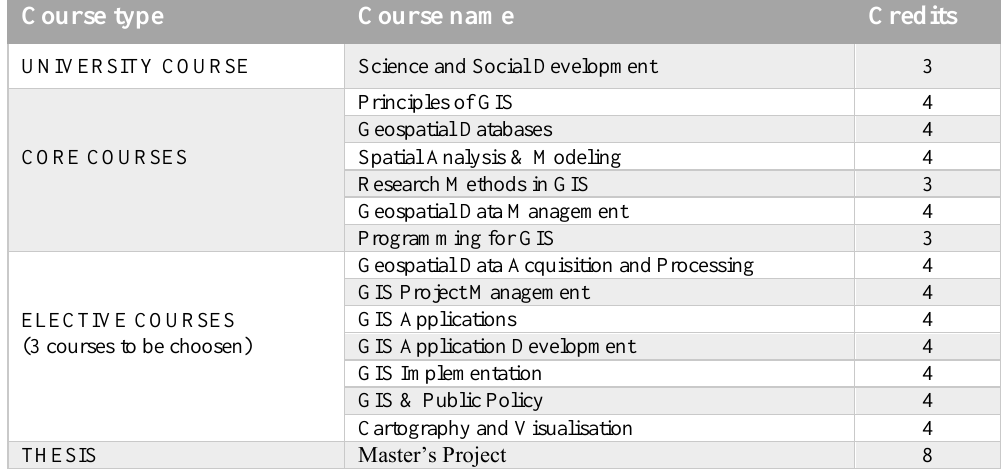
Table 2. Curriculum of M.Sc. in Geoinformatics (by course work) at UTM FGHT.